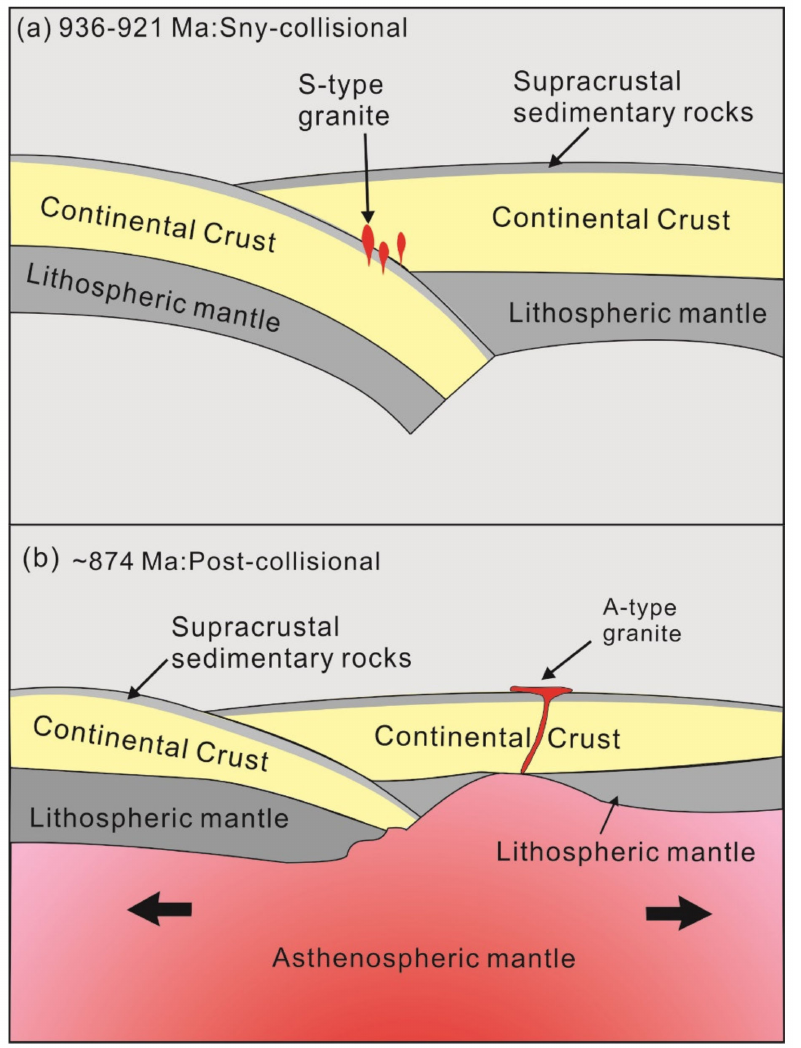
Figure 14. ( a ) Schematic illustrations showing the tectonic evolution of the NQT during the Sny- collisional environment in the early Neoproterozoic. ( b ) Schematic illustrations showing the tectonic evolution of the NQT during the Post-collisional environment in the early